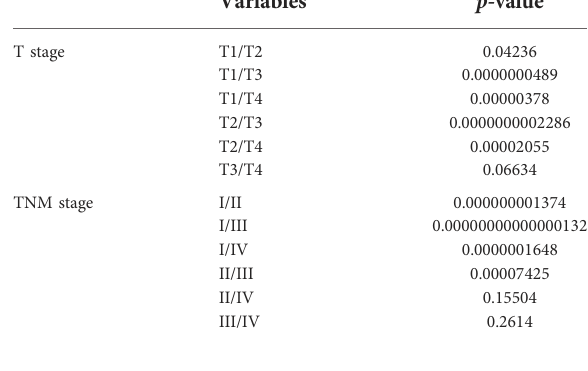
TABLE 3D Kruskal-Wallis test for different T stages and different TNM